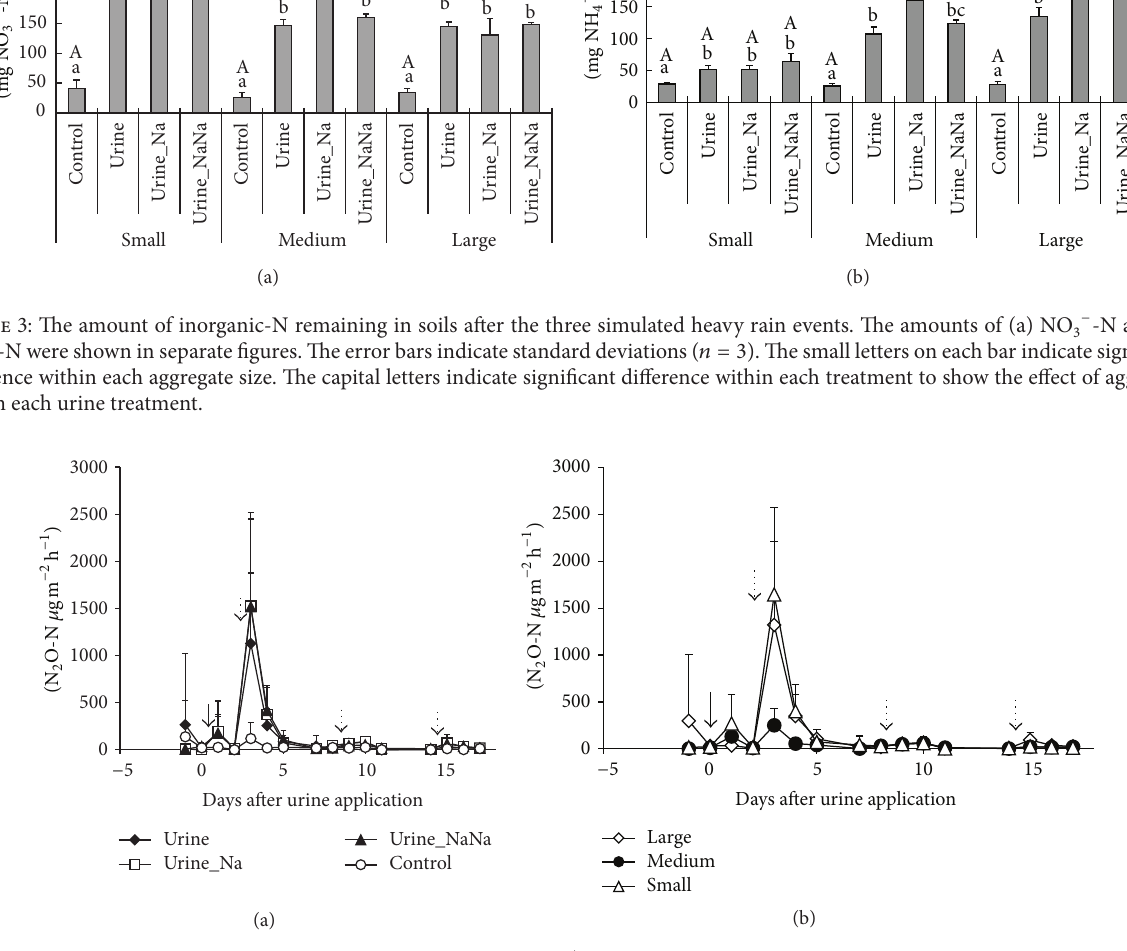
Figure 4: The effects of the application of (a) urine with different Na + concentrations and (b) different aggregate sizes on N 2 O emissions. The timing of urine application is shown as a solid-line arrow. Dotted line arrows indicate the timing of the rain treatment. The error bars are standard deviations ( 𝑛 = 9 for (a) and 𝑛 = 12 for